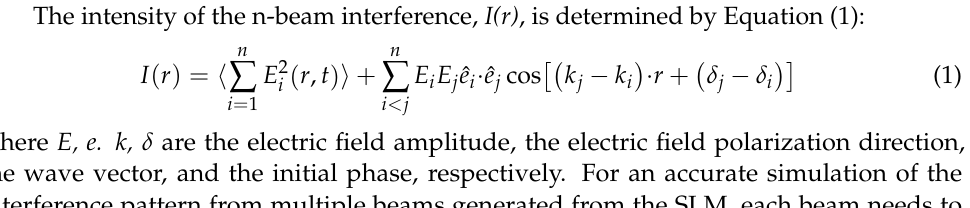
Figure 1. ( a ) Schematic diagram of the experimental setup where incident light is diffracted by the spatial light modulator (SLM), central and inner beams are imaged through a 4f imaging system (f = 400 mm and f = 175 mm), and outer beams are reflected by the single reflective optical element (ROE). ( b ) A design unit of phase patterns in SLM is divided into four quadrants and gray levels of 254, 190 are arranged in checkerboard format in quadrant II and IV, and gray levels of 254, 170 are arranged in checkerboard format in quadrant I and III. ( c ) One central, four inner and four outer beams pass through the Fourier filter. ( d ) Simulated interference pattern of nine beams assuming a simplified phase shift among the interfering beams. Inset is the interference pattern with a different phase shift among beams. ( e ) An enlarged view of 3D interference pattern in an area indicated by the solid square in ( d ). ( f ) Schematic of diffraction measurement setup for three types of